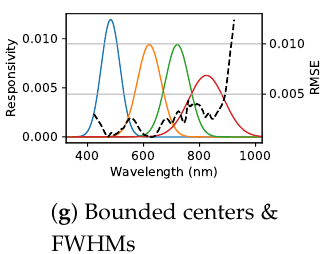
Figure 7. Responsivity of multispectral bands obtained using Aerial images dataset and RMSE across reconstructed bands (dotted line).